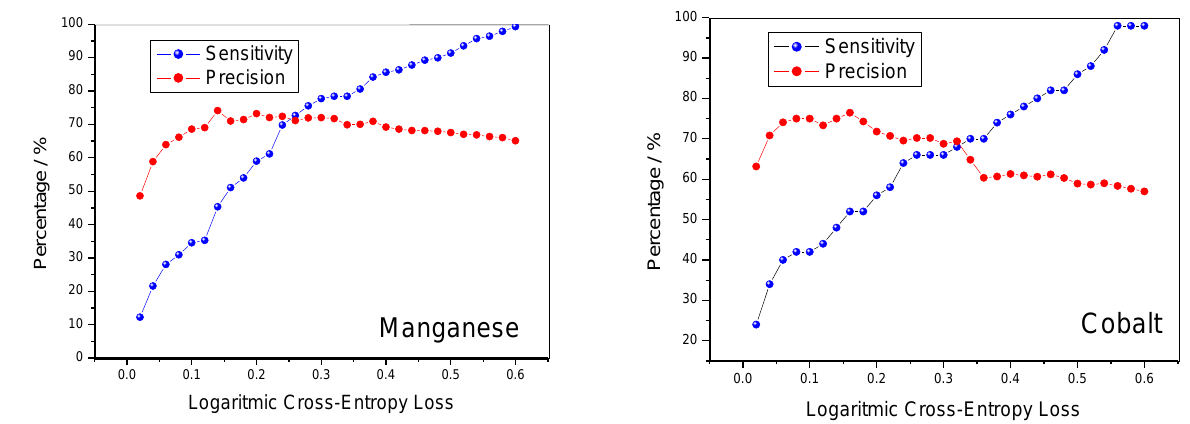
Figure 4. Sensitivity and precision as a function of LCEL value for lithiated manganese ( left ) and cobalt ( right ) oxides.